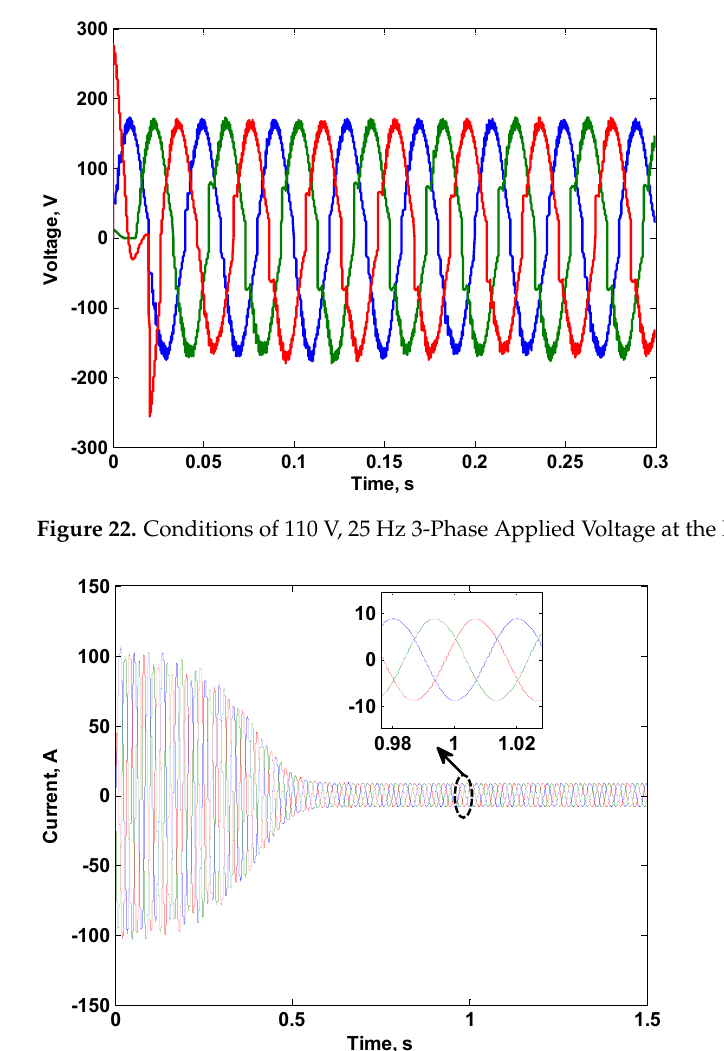
Figure 24. Motor Speed when Excited with 110 V, 25 Hz. Figure 25. Applied Voltage on the 3-Phase Induction Motor, Braking Occurs at 2 s.